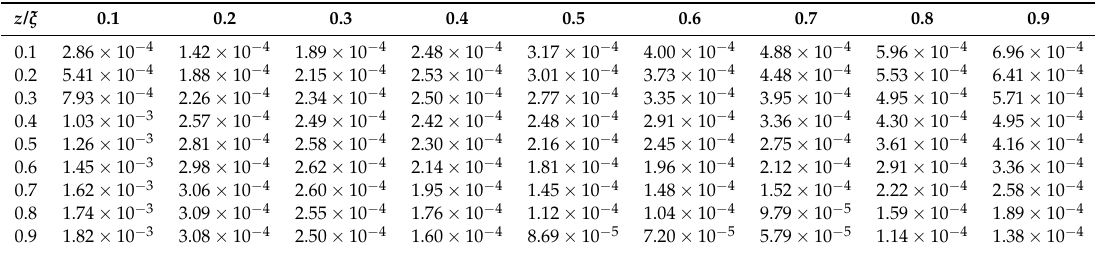
Table 7. Absolute error values of Example 2 for Burgers’ equation with α =